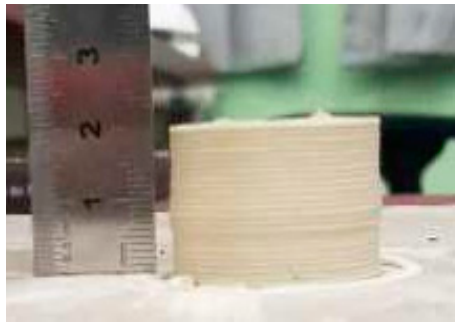
Figure 12. The fully solid cylinder part with in situ hot air flow drying.